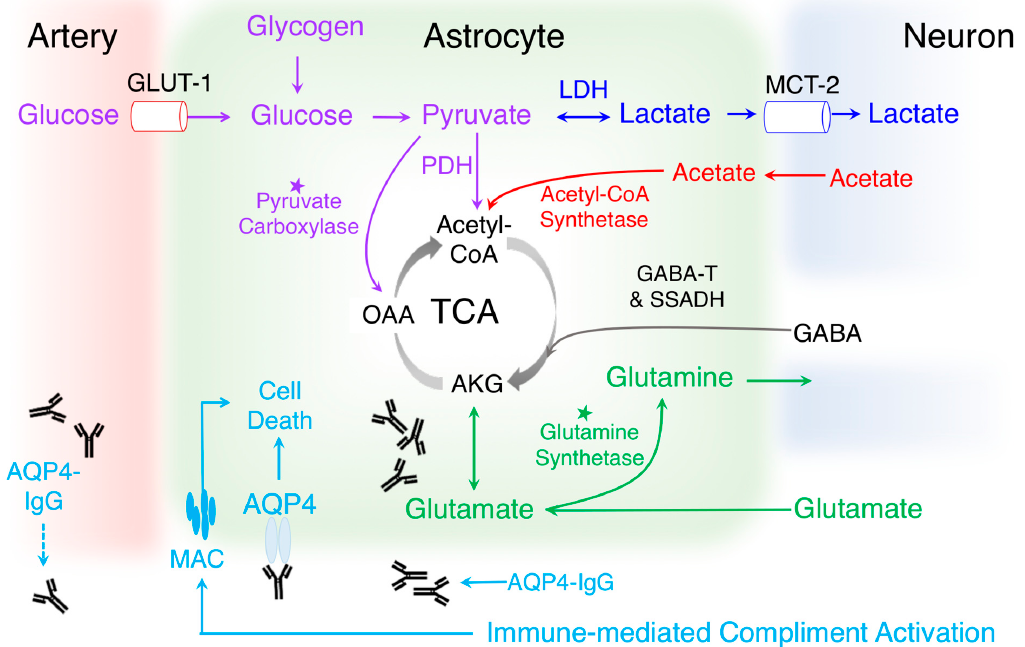
Figure 2. A role for metabolism in NMOSD. The role of astrocytes in neuronal-glial energy metabolism (red), the astrocyte-neuron lactate shuttle (ANLS) (blue), and the glutamate/glutamine shuttle system (green). The pathology of NMOSD, at least in most patients, has been traced to AQP4-Ab, which leads to complement- and antibody-mediated injury and death of astrocytes and neurons. This